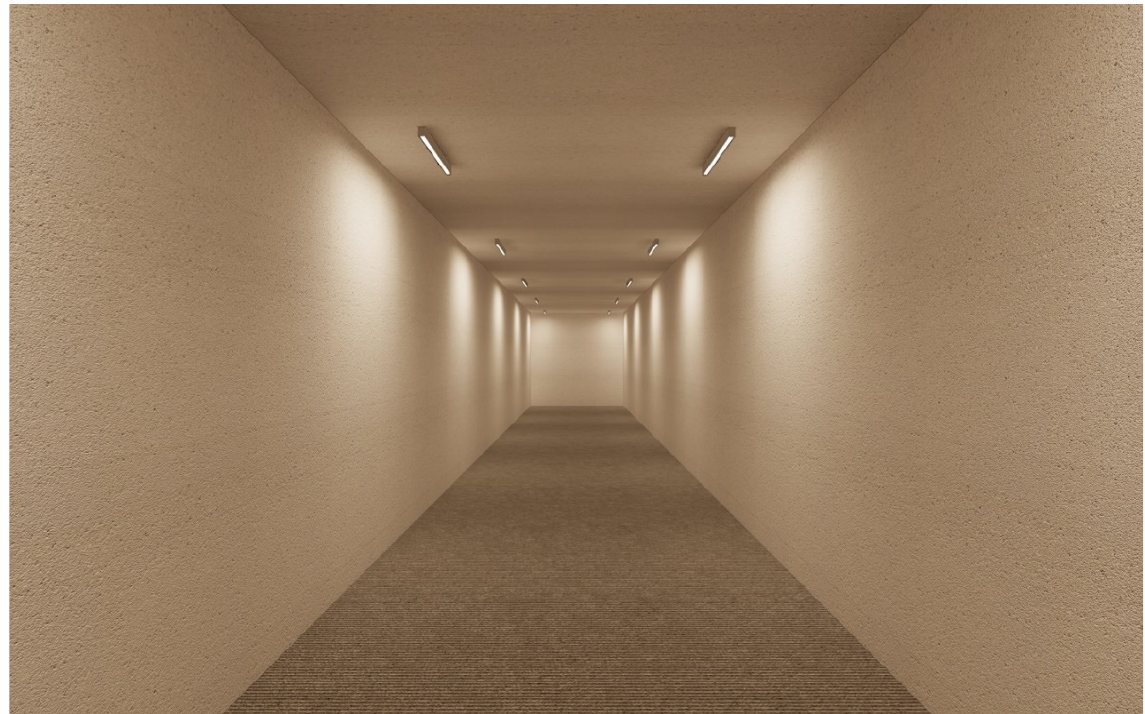
Figure 9. Computer simulation of corridor lighting for variant 6.